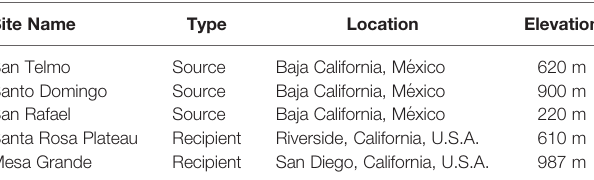
TABLE 1 | Overview of source and recipient sites for reintroduction of the Baja California lineage of R. draytonii